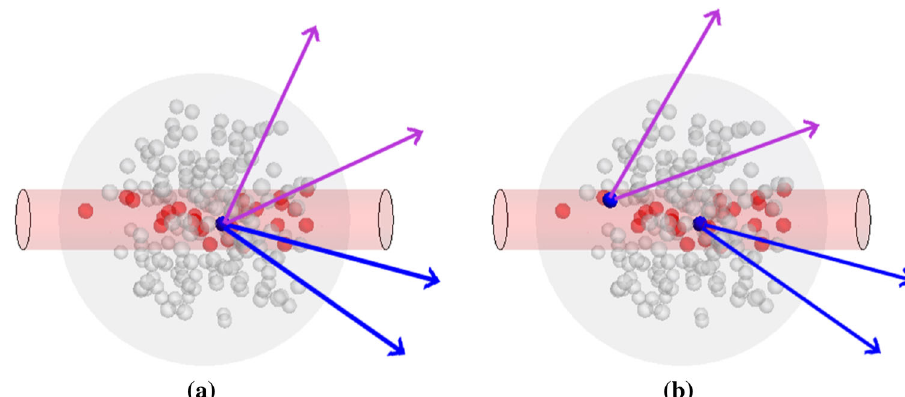
Fig. 2 Sketch of double parton collisions with production of four jets (arrows on the plot) occurring on a single nucleon ( a ) or on two different nucleons ( b ) in the target nucleus. In both illustrations, hard-interacting nucleons are depicted in blue, soft-interacting (wounded) nucleons in red, and spectator nucleons in light grey. The reddish tube represents the incoming proton, and its transverse size is proportional to the pN total cross